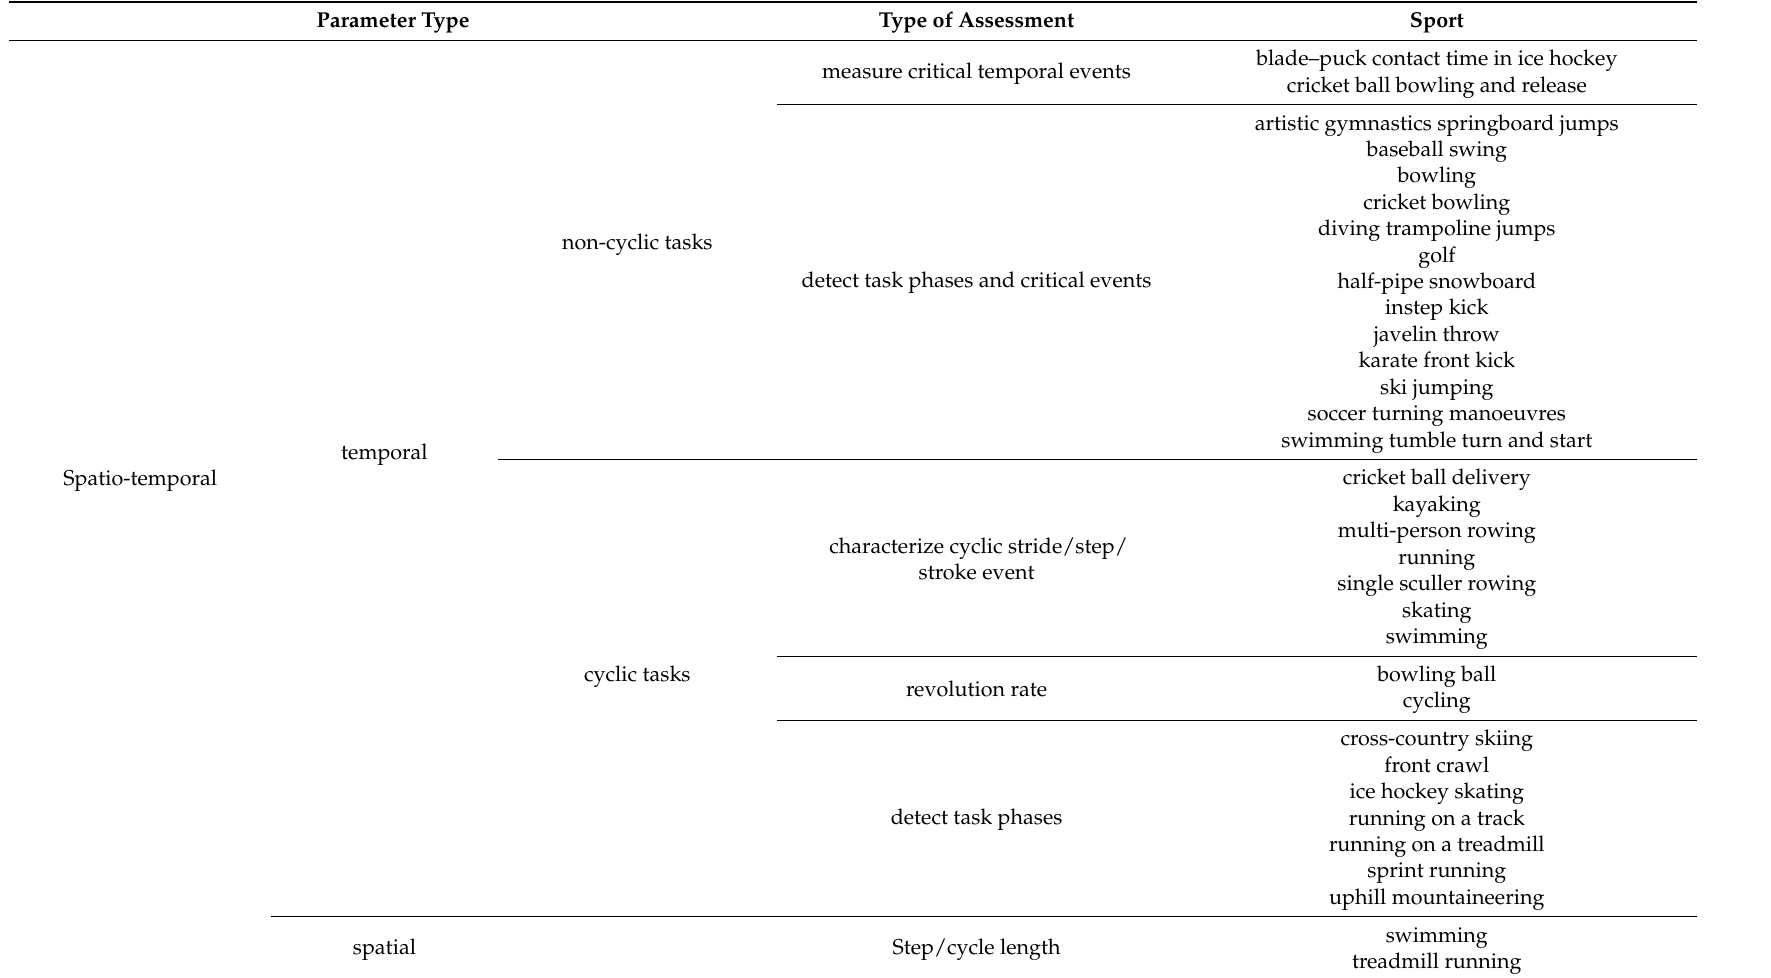
Table 4. Type of parameters, assessments and sports analysed to support sport technique